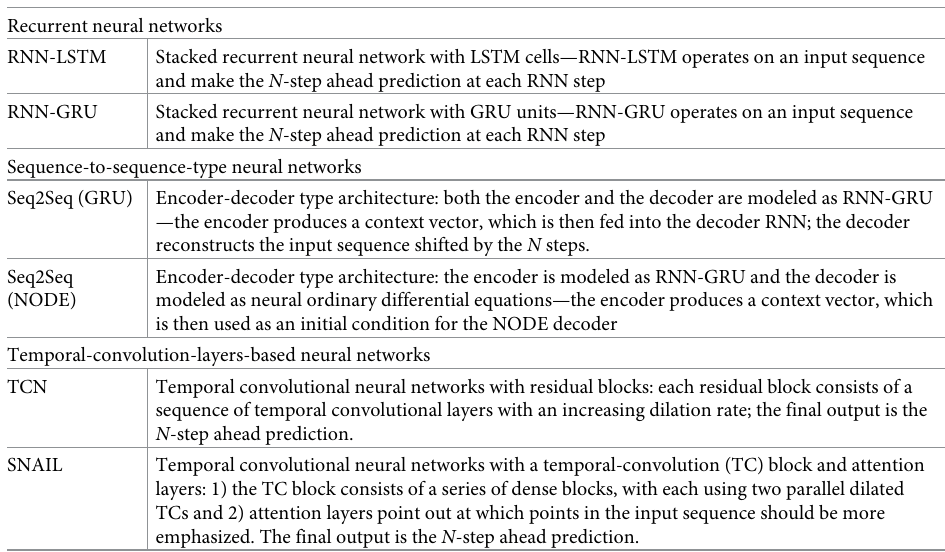
Table 5. Model summary